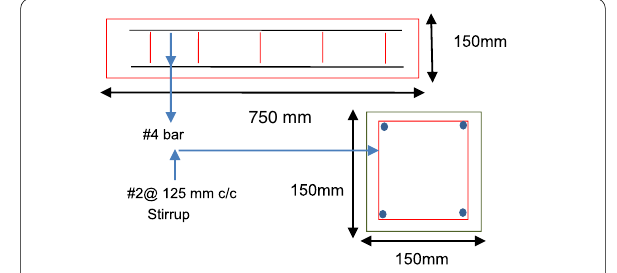
Fig. 5 Beam details for flexure test.